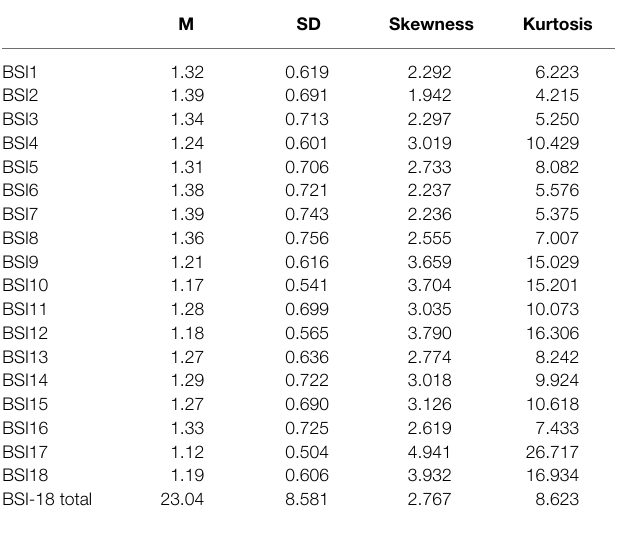
TABLE 2 | Descriptive statistics and skewness and kurtosis ( n = 1,839).